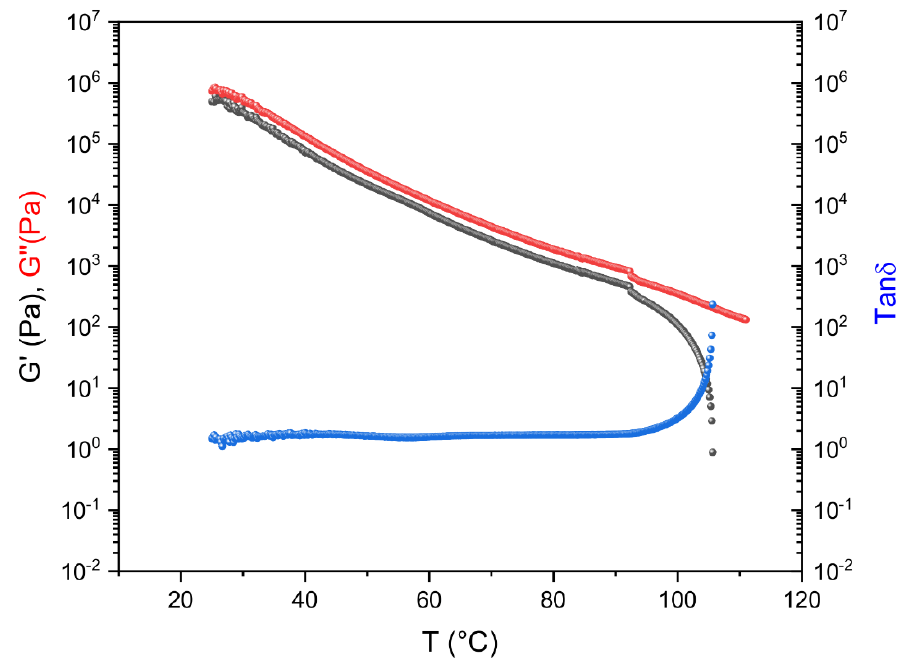
Figure 4. Dynamic Temperature Ramp Test of an SBS-modified bitumen (Pen 50/70 + 3% SBS).